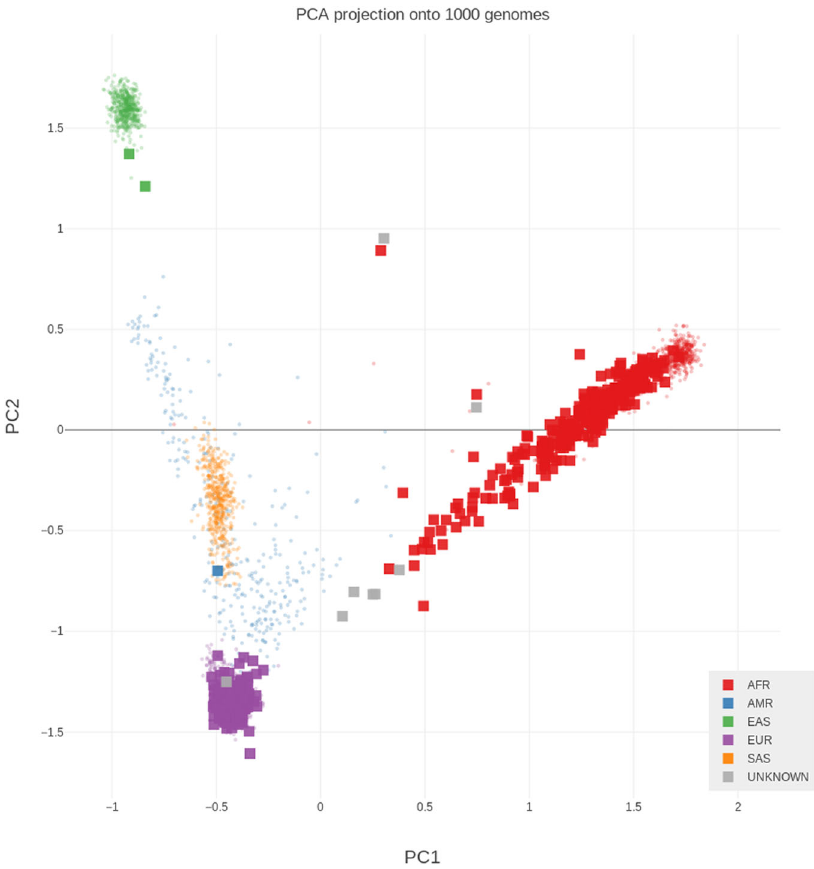
Fig. 1 Principle Component Analysis (PCA) of Ancestry. Using Peddy program 48 , a PCA analysis was conducted on each patient in this study (large square points). Ancestry predictions were made based on an SVM (support vector machine) model trained on the 1000 Genome samples 49 ( n = 2504, small background points). Five superpopulations under 1000 G project are: Africans (AFR) with seven populations, Americans (AMR) with four populations; East Asians (EAS) with fi ve populations; Europeans (EUR) with fi ve populations and South Asians (SAS) with fi ve populations. AFR includes ASW population (African Ancestry in Southwest USA). Source data are provided as a Source Data fi